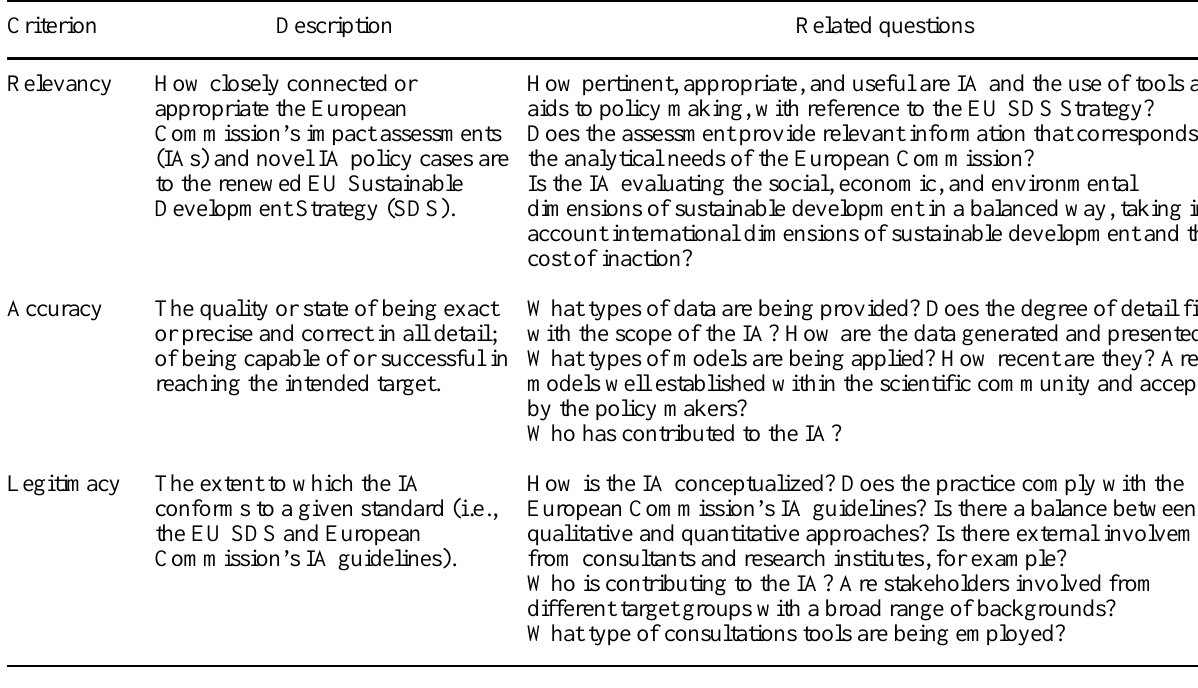
Table 1. Overview of the set of criteria and related questions developed to analyze the use of impact assessment tools to support sustainable policy objectives (after EPA